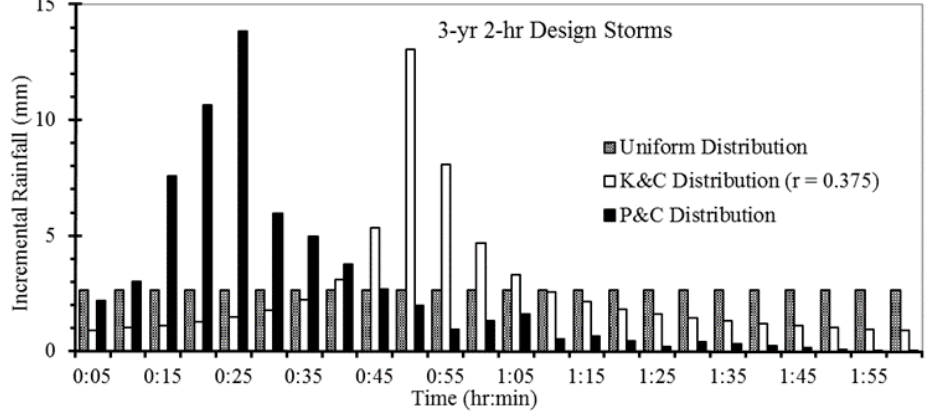
Figure 2. Three rainfall distributions used in SWMM model simulations for three ‐ year, 2 ‐ h Beijing design storms.